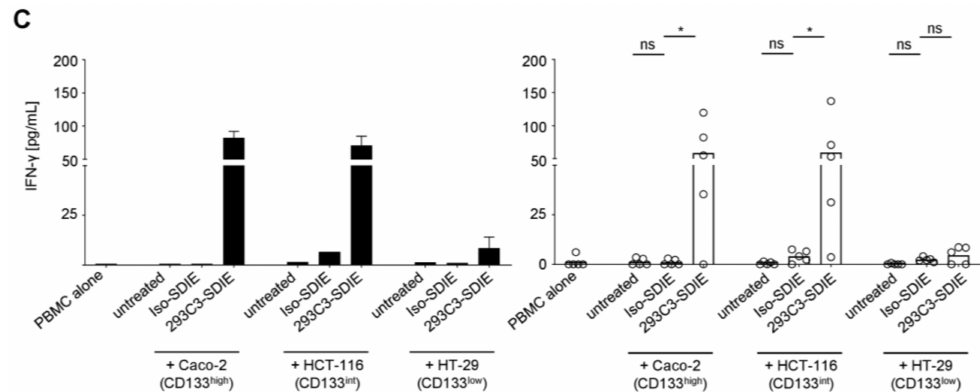
Figure 4. Induction of natural killer (NK) cell activity by 293C3-SDIE in the presence of colorectal cancer (CRC) cells. Peripheral blood mononuclear cells (PBMC) of healthy donors were cultured with or without the indicated CRC cell lines at an e ff ector to target ratio of 2.5:1 in the presence or absence of 293C3-SDIE / Iso-SDIE (1 µ g / mL). On the left, exemplary results obtained in a single experiment with PBMC of a single donor are shown; right panels depict combined analyses of data obtained with PBMC from five independent donors (bars represent respective means). ( A ) Activation of NK cells identified as CD14-CD56 + CD3- cells within PBMC was determined after 24 h by flow cytometry for CD69. ( B ) Cells were cultured for 4 h in the presence of anti-human CD107a-PE / GolgiStop / GolgiPlug and NK cells subsequently analyzed by flow cytometry for CD107a as surrogate marker for degranulation. ( C ) Cells were cultured for 6 h before supernatants were analyzed for Interferon (IFN)- γ by an enzyme-linked immunosorbent assay. Int: intermediate; ns: not significant; *: significant ( p -value < 0.05).